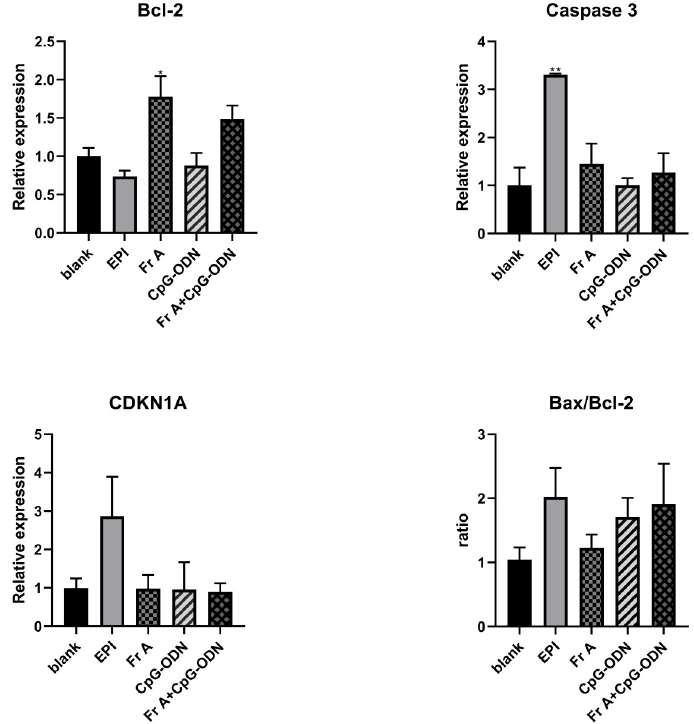
Figure 6. Effects of Frondoside A (Fr A), CpG-ODN individually and in combination in bladder cancer cells of TP53 signaling and Intrinsic pathways. Cells were treated with the indicated concentrations of Frondoside A and CpG-ODN for 48 h, EPI (10 µ M) as positive control. Equal amounts of cell extracts were analyzed by Quantitative Real-Time Polymerase Chain Reaction assay with TP53, Bax, Bcl-2, Caspase 3, and CDK1A. Data represent the mean ± S.E.M. * Significantly different at p < 0.05. ** Significantly different at p < 0.01. *** Significantly different at p < 0.001.